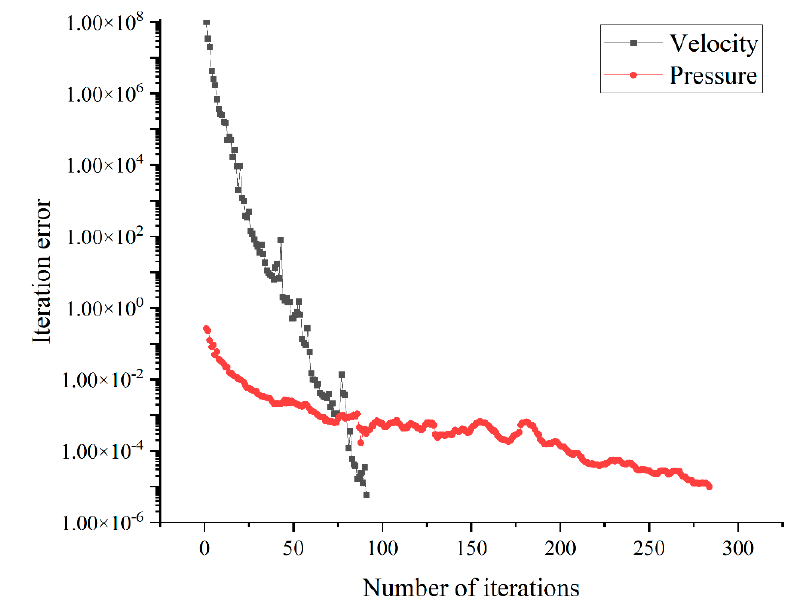
Figure 1. Iterative convergence processes of velocity and pressure.